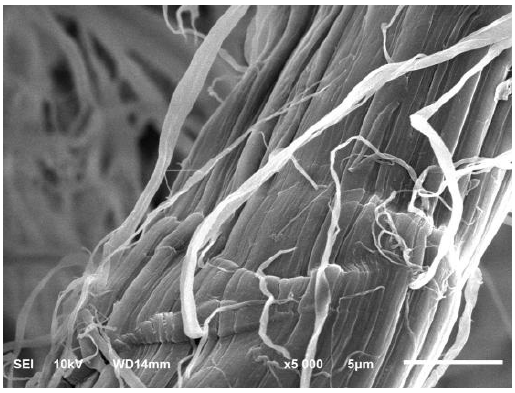
Figure 4. SEM image of aramid fiber after surface treatment with acetic anhydride for 1 h.